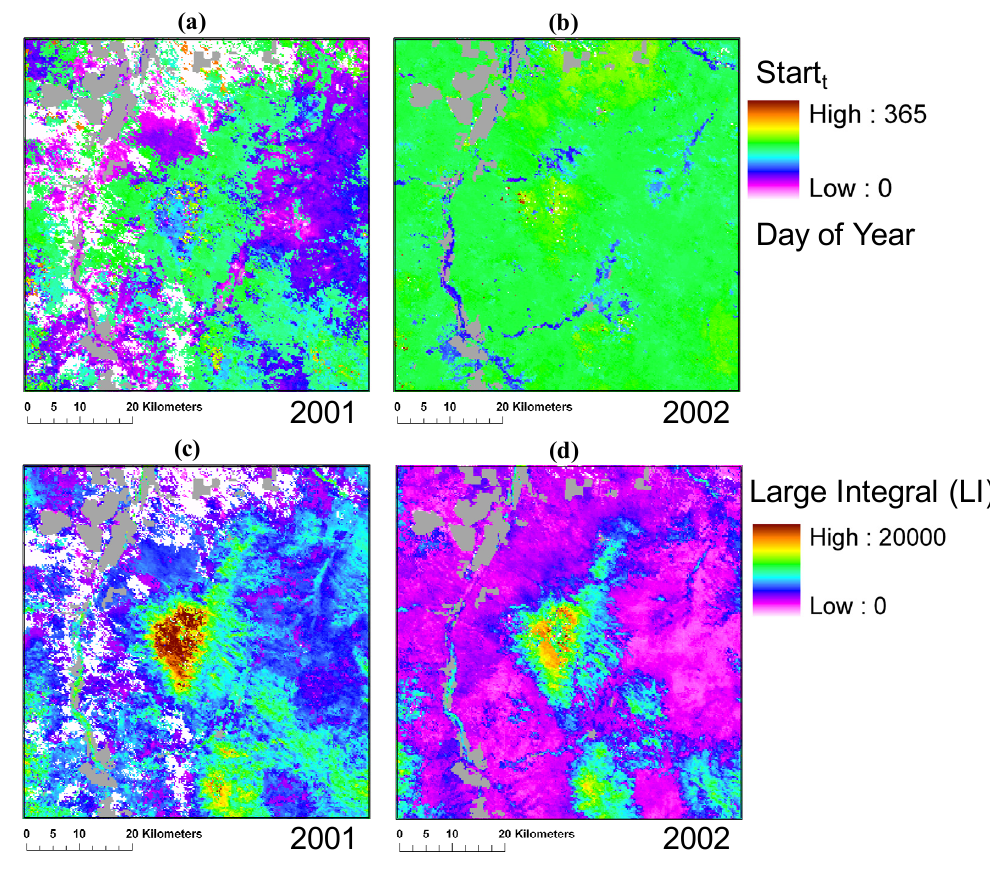
Figure 7. Start of season (Start ; Day of Year) and for (a) 2001 and (b) 2002, and Large t Integral for (c) 2001 and (d) 2002 across the Santa Rita Mountains, AZ. Gray areas are agricultural or industrial land cover types and are excluded from analysis while white areas represent incomplete phenological retrievals for that